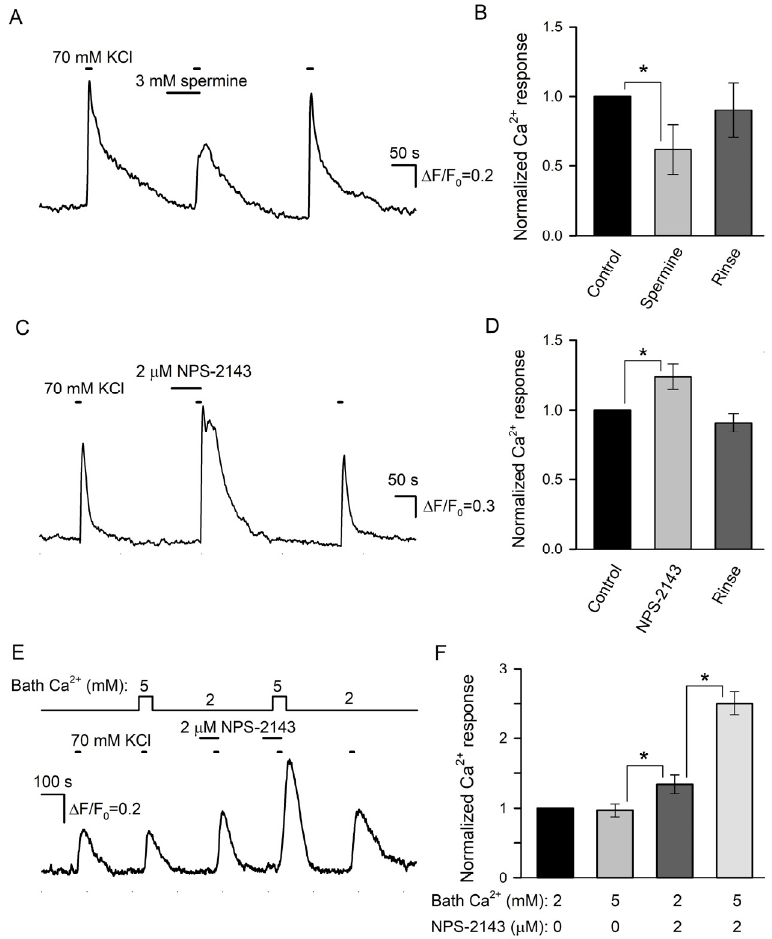
Figure 6. Effects of CASR ligands on depolarization-induced Ca 2+ signals in type III taste cells. ( A ) Spermine (3 mM) reversibly diminished Ca 2+ transients elicited by cell depolarization by 70 mM KCl. The cell was loaded with the Fluo-8 dye. ( B ) Averaged Ca 2+ responses to 70 mM KCl recorded